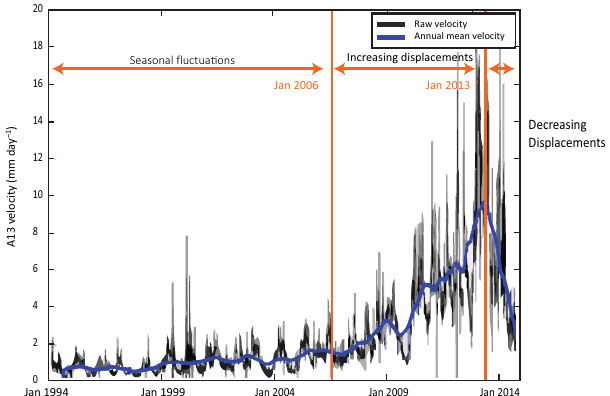
Figure 2. Velocity in mmday − 1 at extensometer A13 from 1 Jan- uary 1994 until 31 March 2015 (black), and annual mean velocity (blue; Dubois et al.,